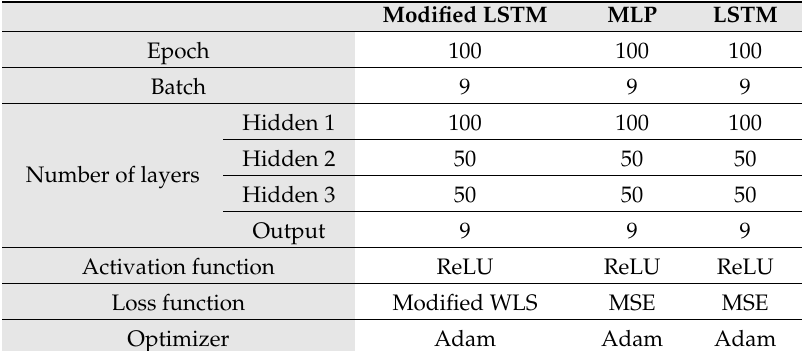
Table 1. Specifications of the deep-learning-based state